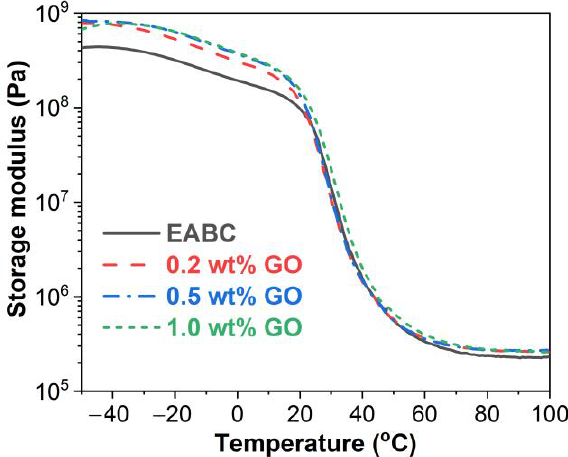
Figure 7. Storage modulus versus temperature curves of the unmodified and GO-modified EABCs.